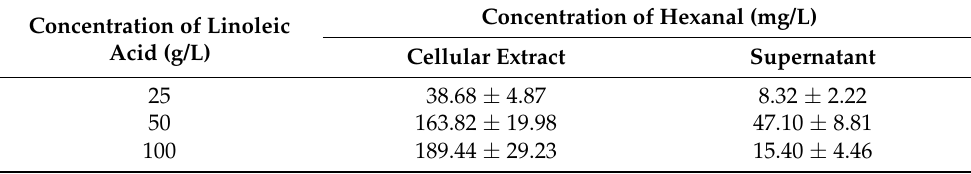
Table 4. Influence of linoleic acid concentration on the level of hexanal biosynthesis by Yarrowia lipolytica